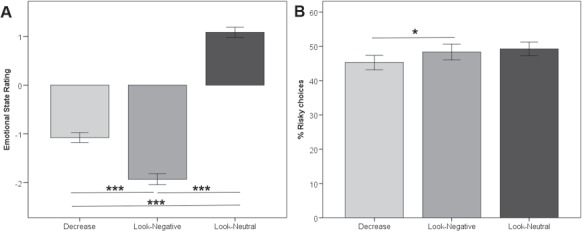
Physiological and behavioral results. (A) Emotional state ratings after each trial (fMRI study). The subjective ratings of emotional states indicated fewer negative emotions after the down-regulation of emotions compared to Look-Negative. During the Look-Neutral condition, participants rated their emotional state to be significantly less negative compared to the Decrease and Look-Negative condition. (B) Percent risky choices as a function of preceding emotion regulation (fMRI study). After emotion regulation, participants showed less risk-taking behavior, i.e. they chose the safe option more often compared to the Look-Negative condition. * indicates P < 0.05; ** indicates P < 0.01; *** indicates P < 0.001.